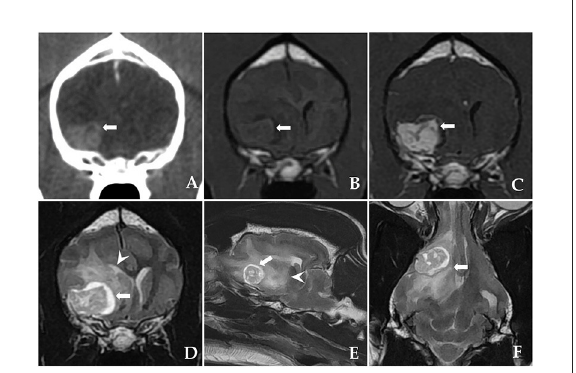
FIGURE1 Postcontrast computed tomography (CT) and pre-operative magnetic resonance imaging (MRI) showing a sphenoid-wing meningioma with a large eccentrically located cystic structure in a dog. (A) A postcontrast transverse CT image: the mass is intensely and uniformly enhanced. The mass is well-marginated and broad-based, indicating an extra-axial origin. (B) T1-weighted (T1W) transverse image: an isointense mass is discovered under the right sphenoid wing. (C) Post-contrast T1W transverse image and T2-weighted (T2W) images showing (D) transverse, (E) parasagittal, and (F) dorsal heterogenous contrast-enhancement (arrow) with intratumoural accumulation of fluid and peritumoural oedema